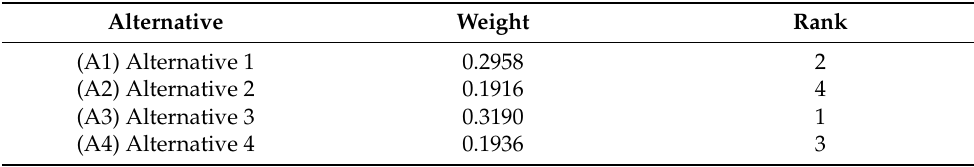
Table 11. Significance and ranking of the